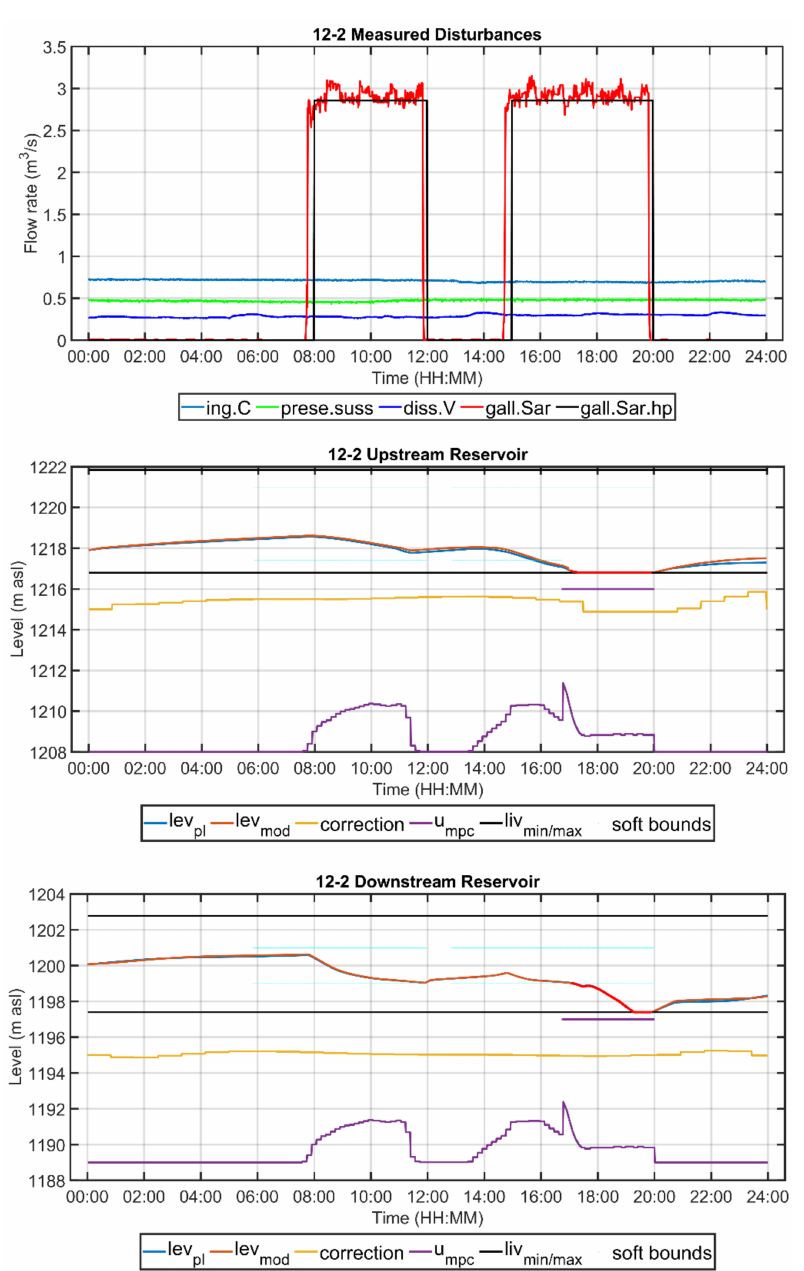
Figure 17. Virtualenvironmentresults: measureddisturbances, upstreamreservoir,